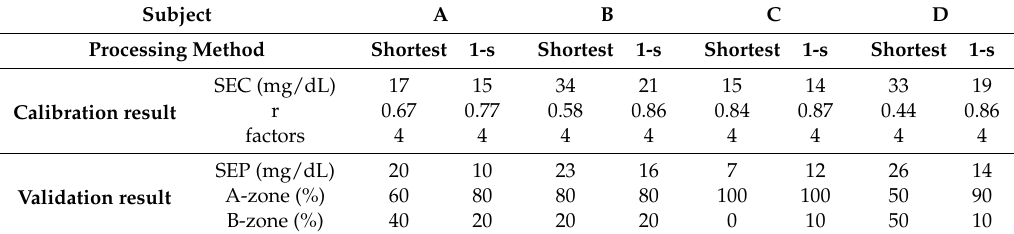
Figure 5. Calibration curve and validation results for calculated blood glucose level (Subject: D, shortest-time-cut and 1-s-normalization processing). ( a ) Sub.D-calibration curve in Shortest; ( b ) Sub.D-validation result in Shortest; ( c ) Sub.D-calibration curve in 1-s; ( d ) Sub.D-validation result in 1-s. Table 2. Calibration curve and validation results for each subject.